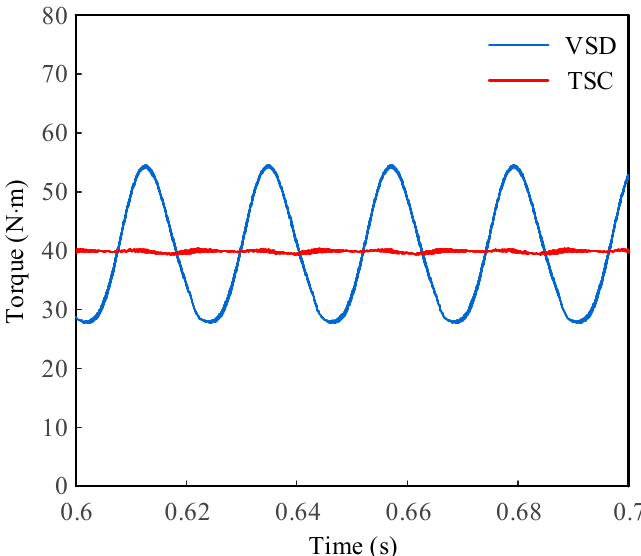
Figure 7. Torque waveforms for the non-fault-tolerant decoupling control and the TSC fault-tolerant control.